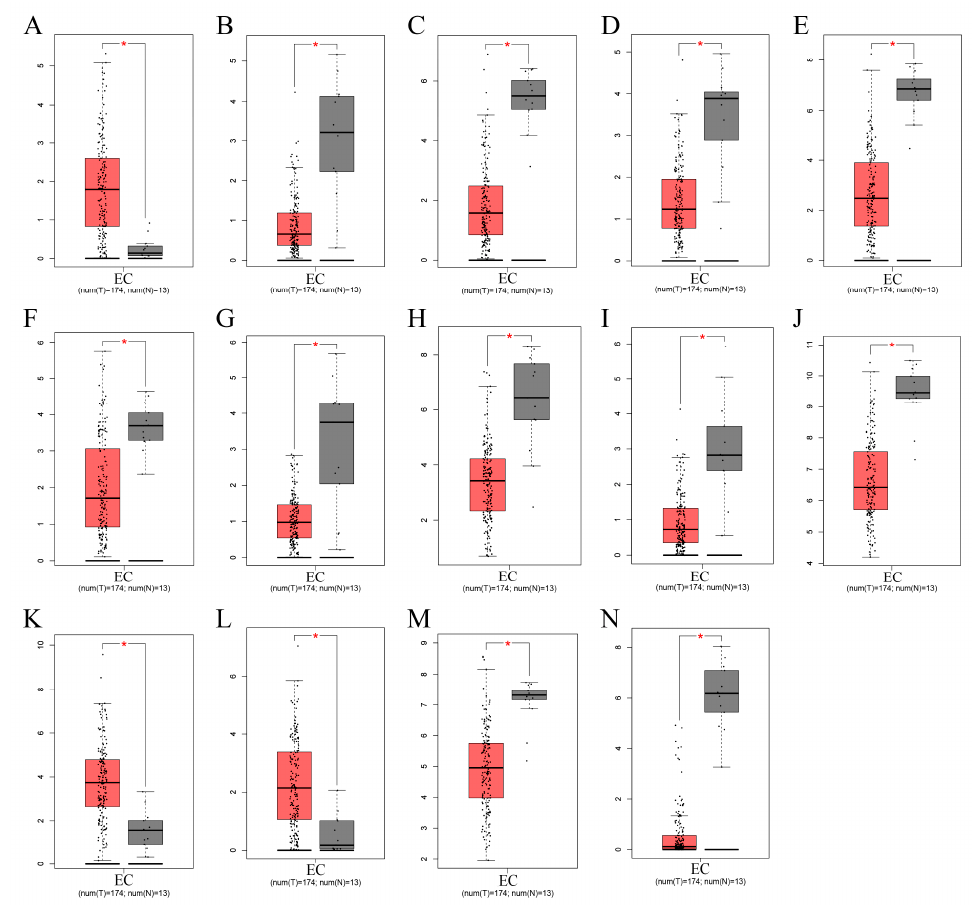
Figure 4. Box diagram of 14 characteristic genes in EC and healthy controls with p -value < 0.01. ( A – N ) ADAMDEC1, ADAMTS5, ALDH1A2, DCHS1, EFEMP1, EFS, ENPEP, ENPP2, FOXL2, IGFBP4, MMP9, MMP12, MXRA8, and OGN. The red color represents EC, and the black color represents healthy controls. * means p -value < 0.01.